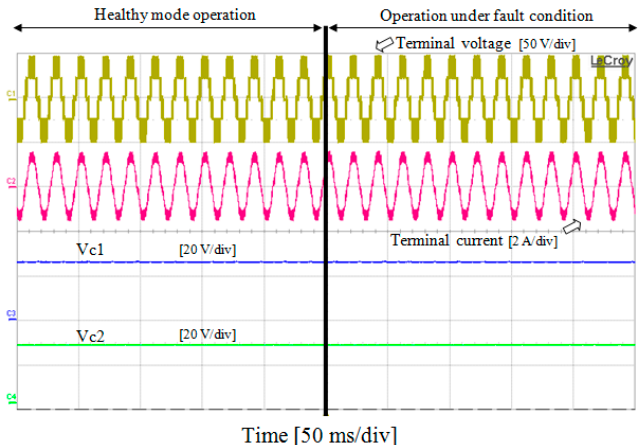
Figure 14. Experimental results of the inverter operation with fault-tolerant control in case of fault event in S 11 .